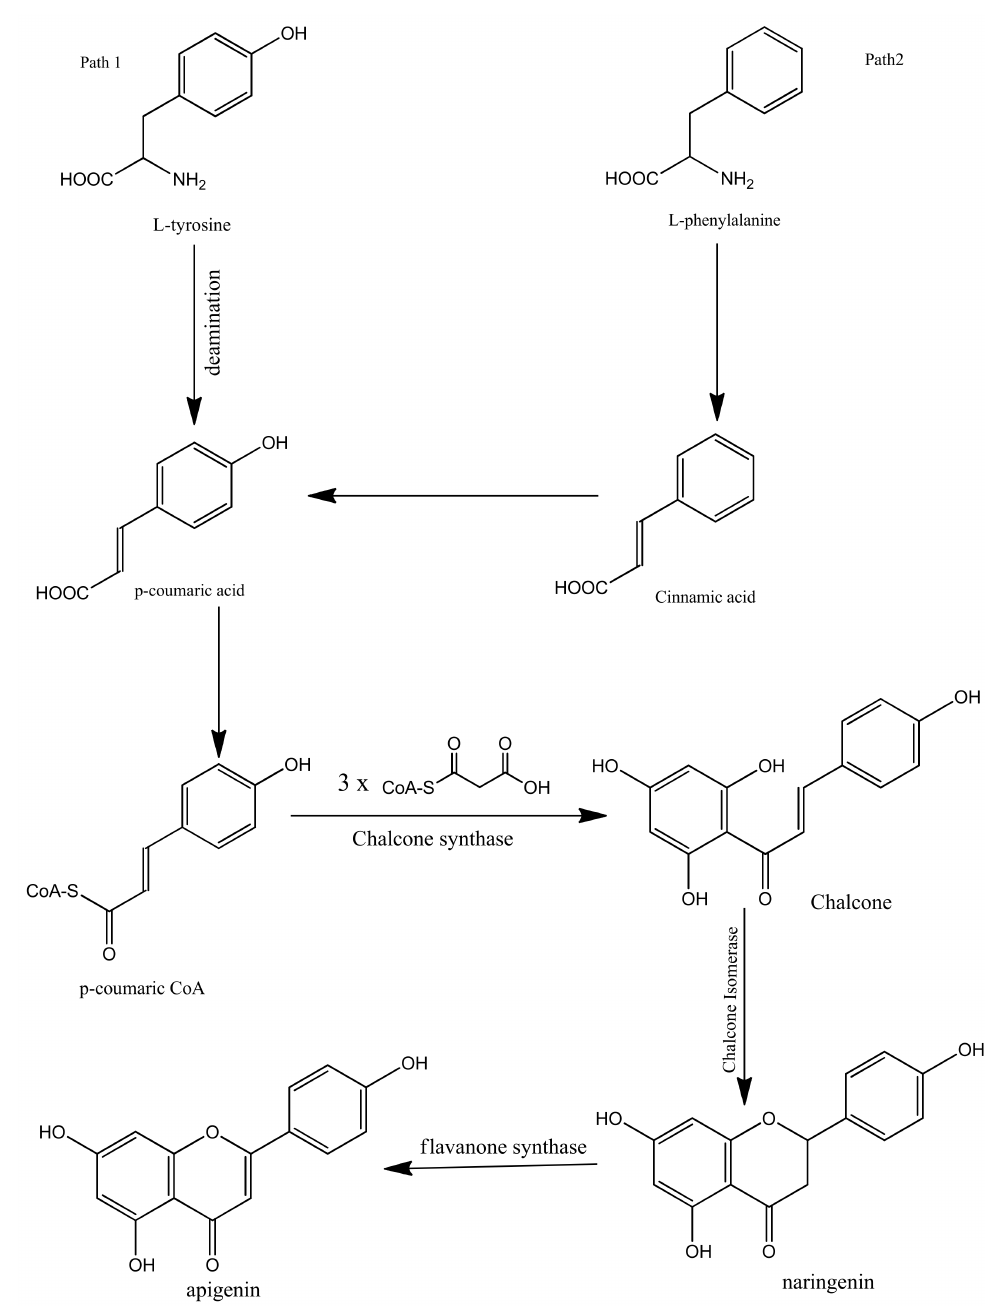
Figure 2. Biosynthesis of